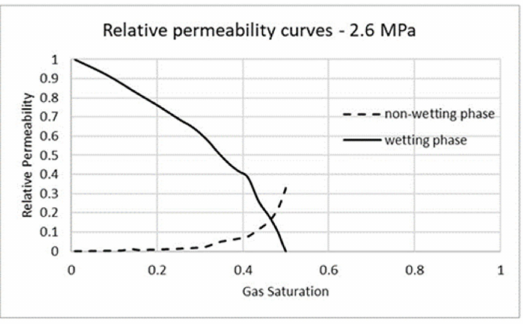
Figure 10. Relative permeability curves at inlet pressure of 2.6 MPa.